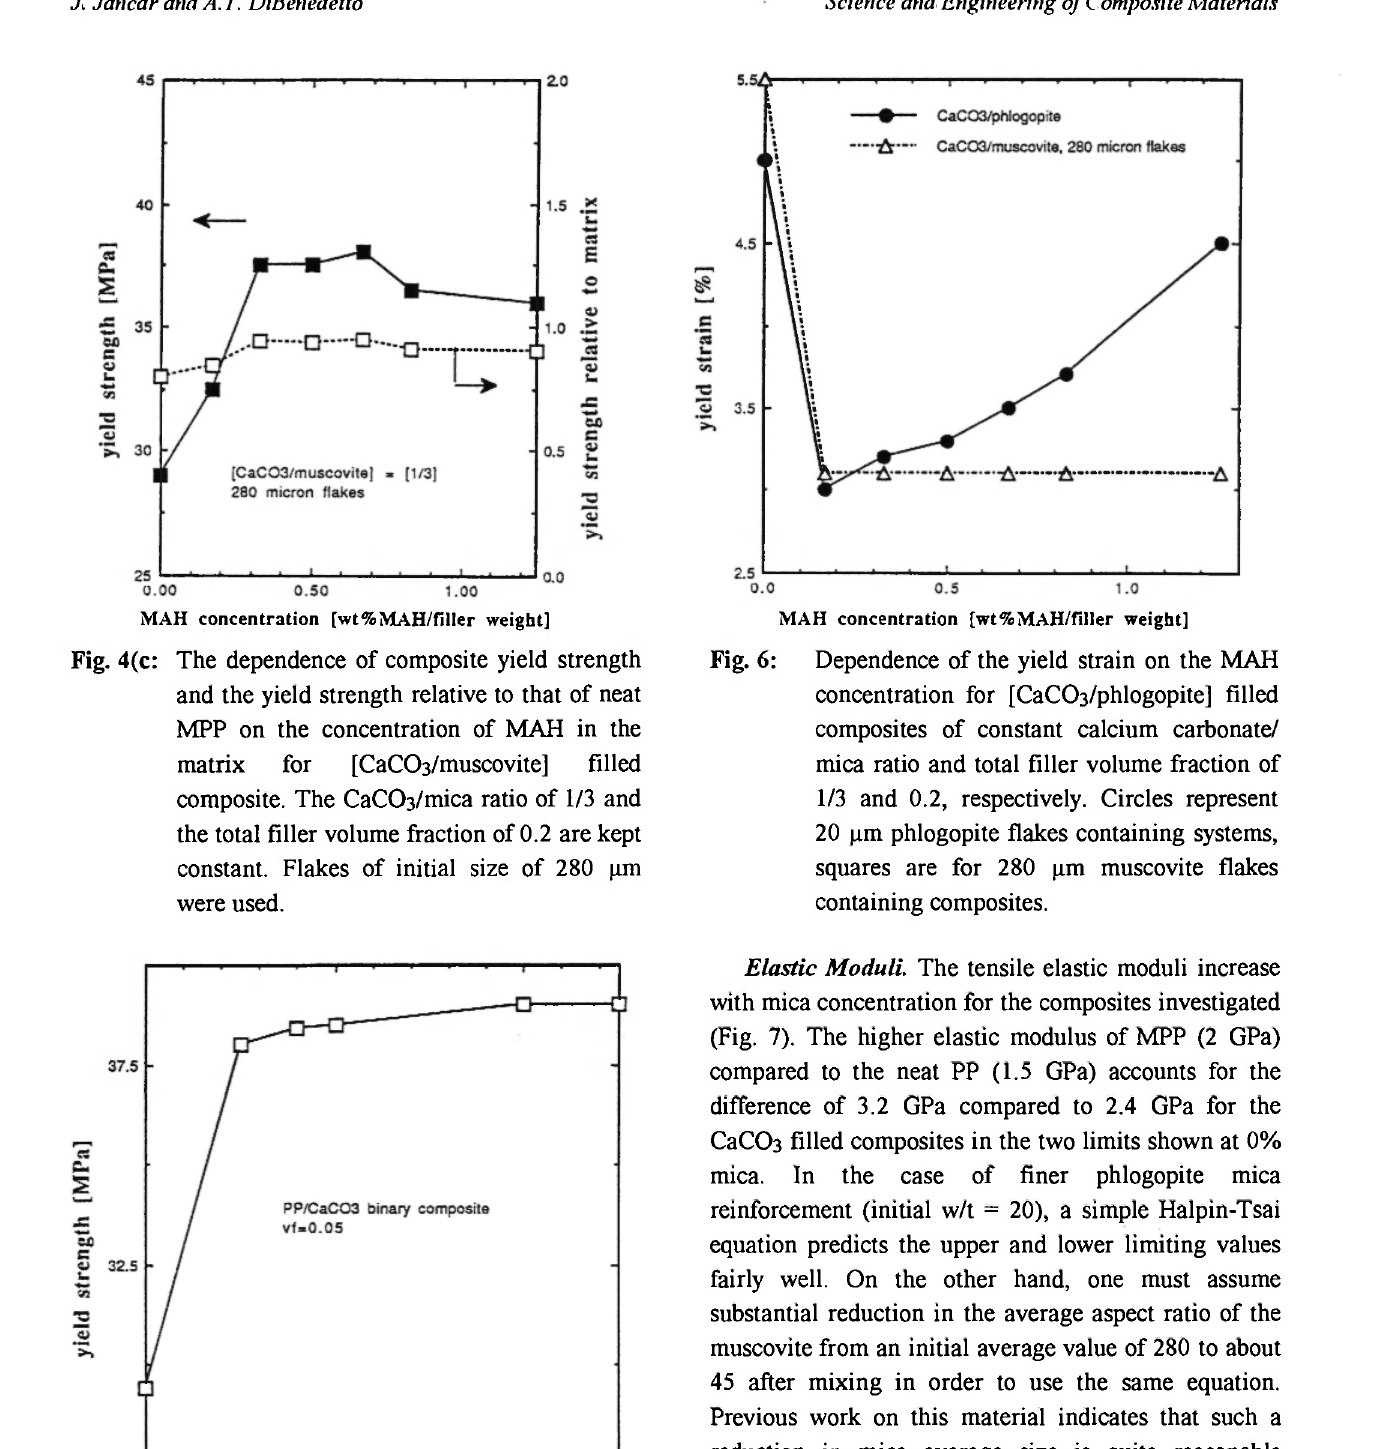
ΜΑΗ concentration [wt%/filler weight] Fig. 5: Concentration dependence of the composite yield strength for MPP filled with 5 vol.% CaC0 3 .